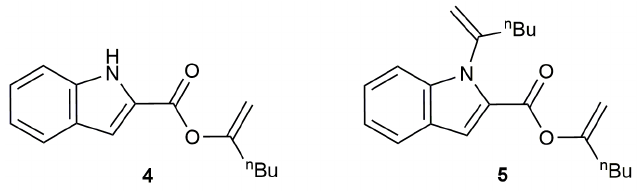
Figure 1. Structure of the novel enol esters 4 and 5 .